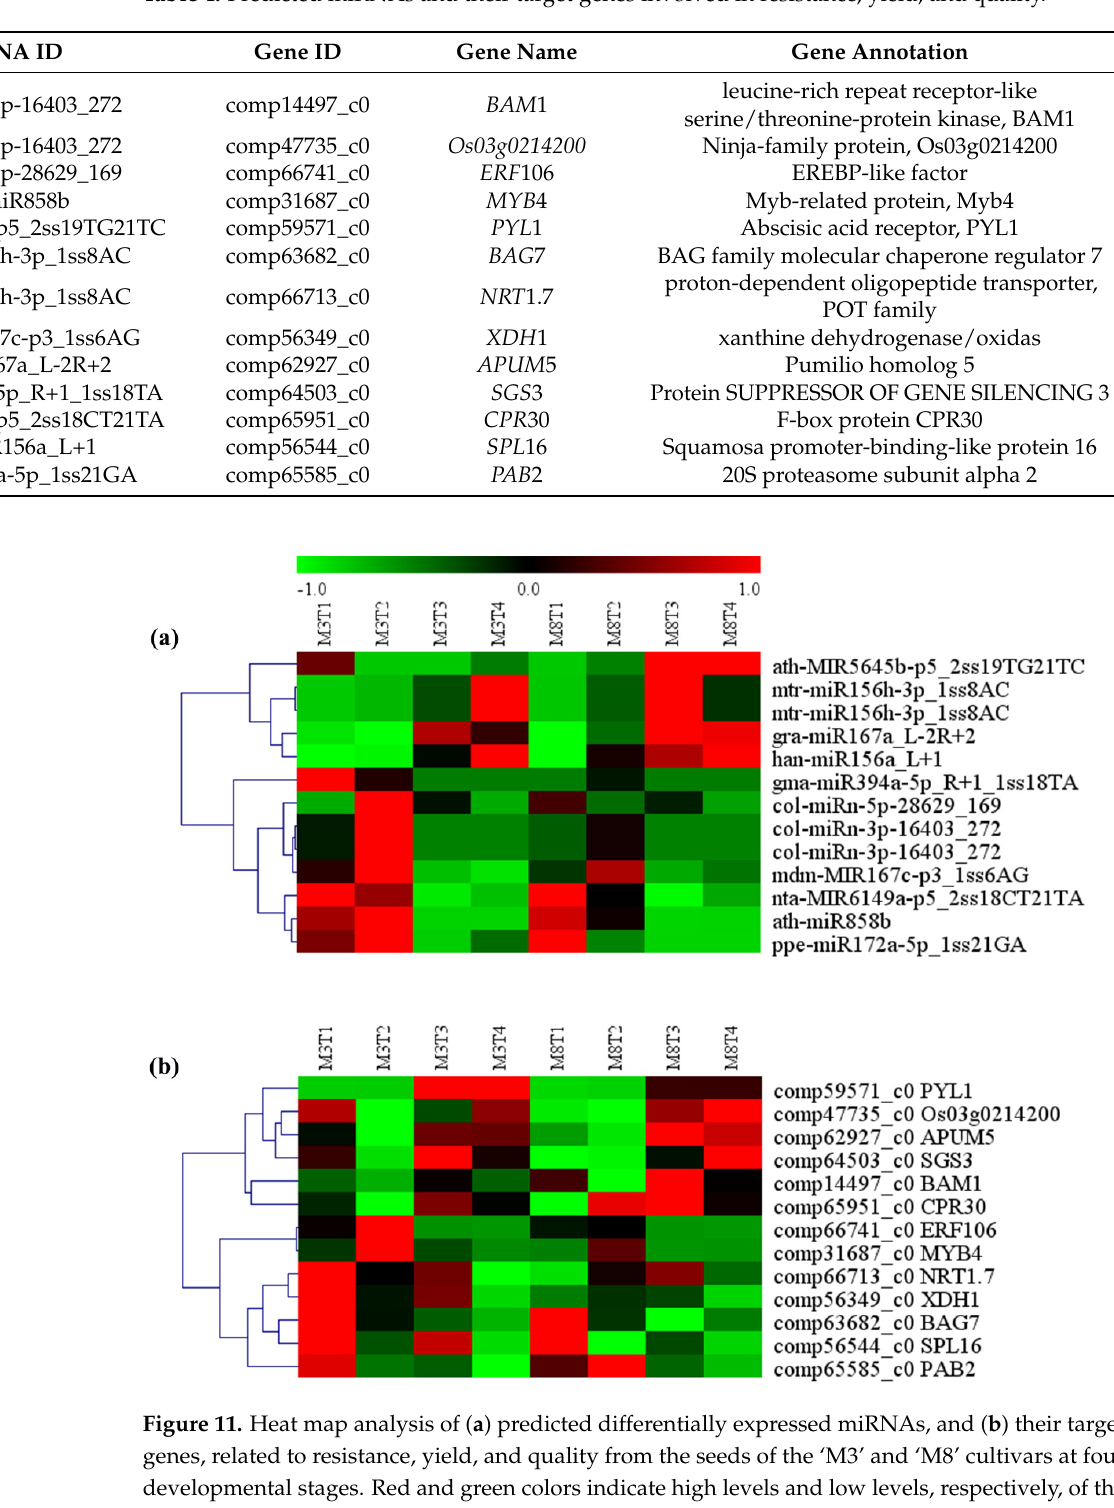
Table 4. Predicted miRNAs and their target genes involved in resistance, yield, and quality.